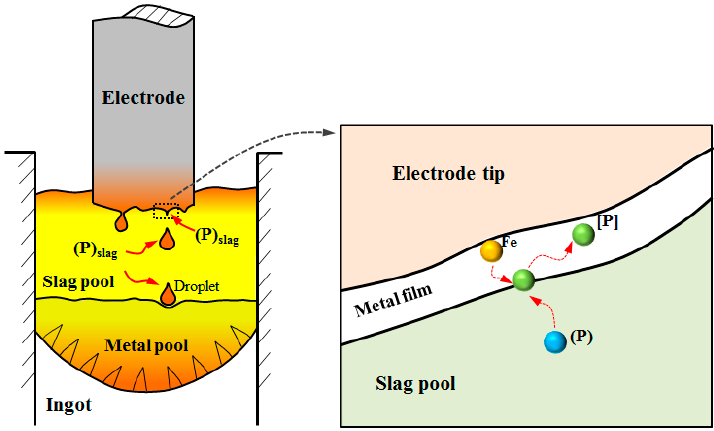
Figure 11. The corresponding maximum P content in slag A under certain P content in electrode, when the P content of the ingot is maintained at 0.015%.